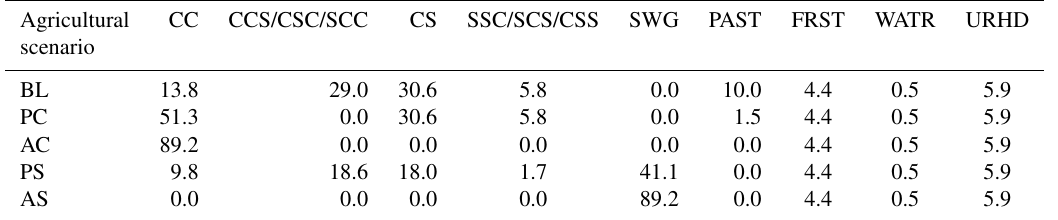
Table 1. Percentage of crop rotations and LULC in each agricultural scenario considered (BL is Baseline, PC is partial corn, AC is all corn, PS is partial switchgrass, AS is all switchgrass).